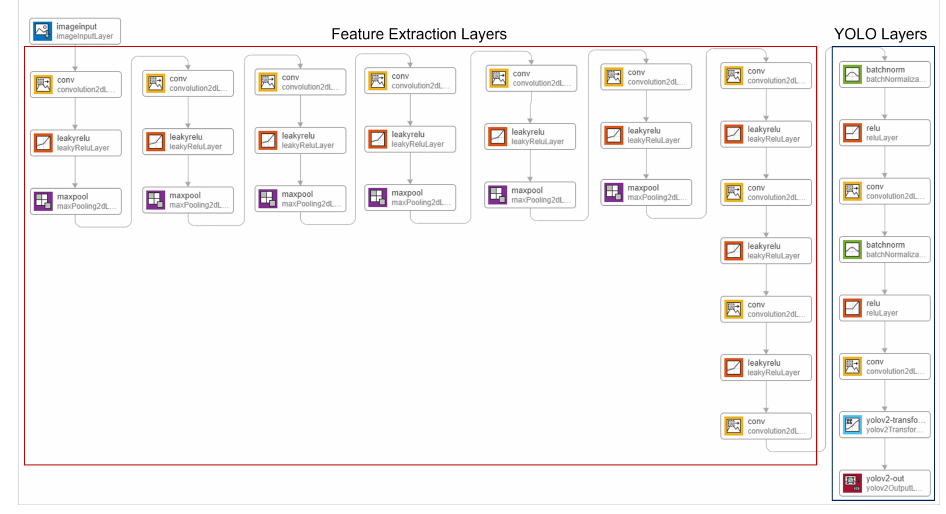
Figure 8. YOLOv2 with TinyYOLO feature extraction.